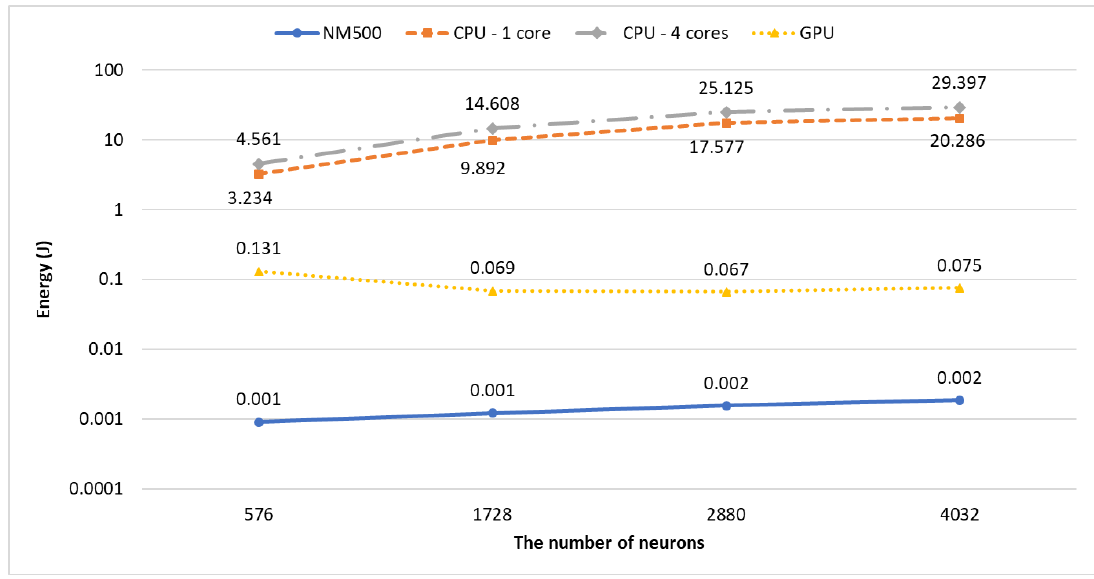
Figure 5. Energy per training data.